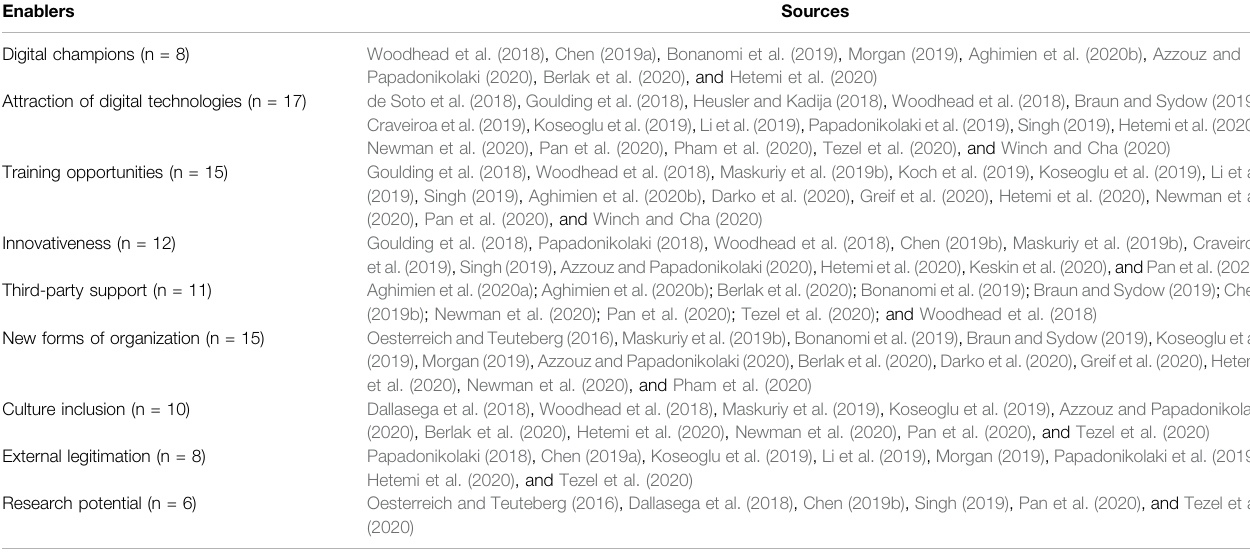
TABLE 4 | Summary of inductive literature on enablers of DT in